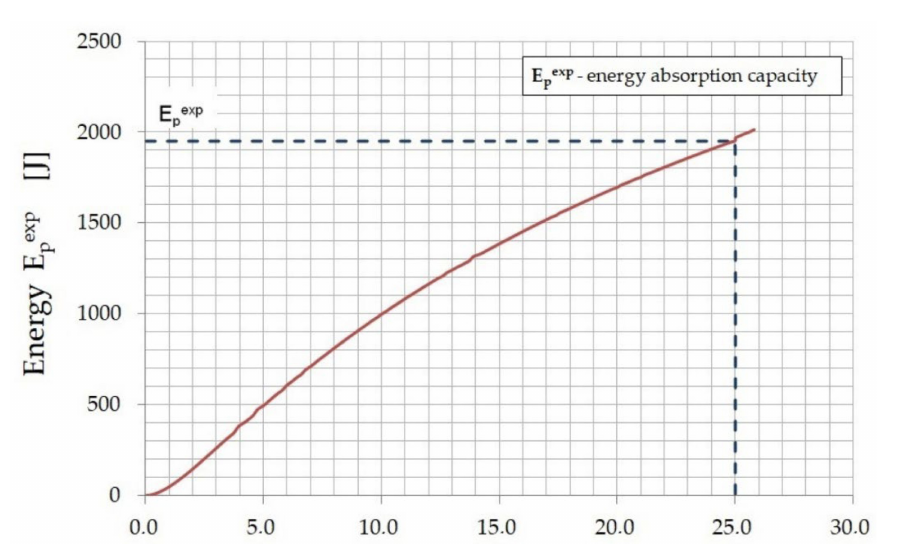
Figure 10. The energy (E pexp ) of the deflection in the center of the plate ( δ p.exp ) for the tested fiber